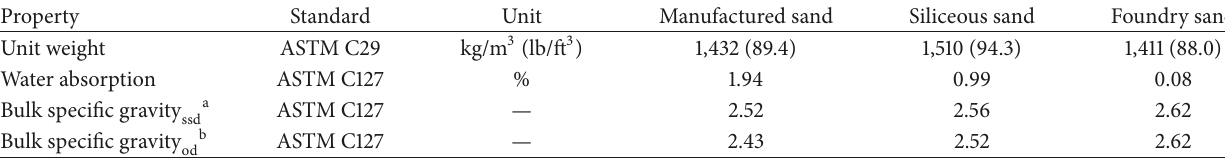
Table 4: Physical properties of aggregates and foundry sand.